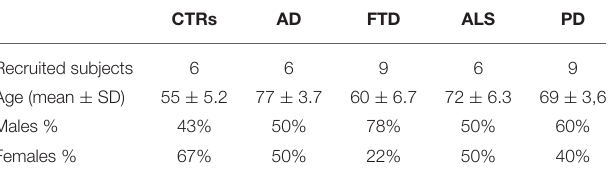
TABLE 1 | Baseline characteristics of recruited subjects for this